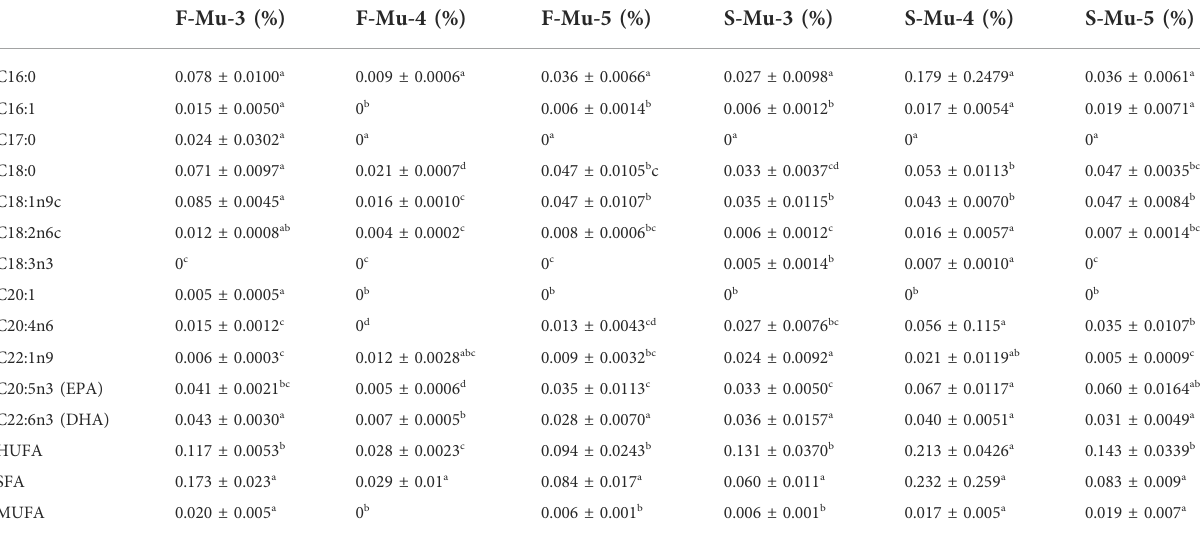
TABLE 10 Pro fi le of fatty acids in female Scylla paramamosain muscle during the two vitellogenesis periods. F-Mu-3